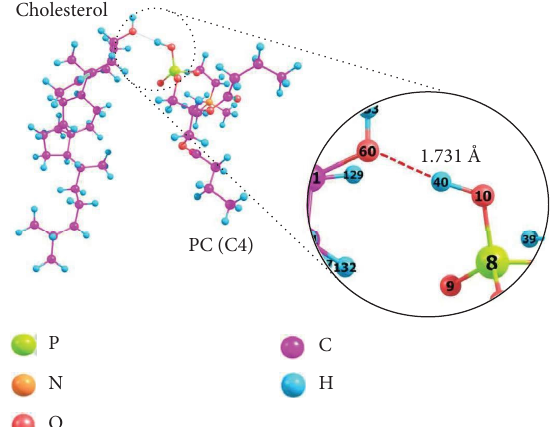
Figure 2: Te interaction of phospholipid and cholesterol mole- cules using an optimized structure.